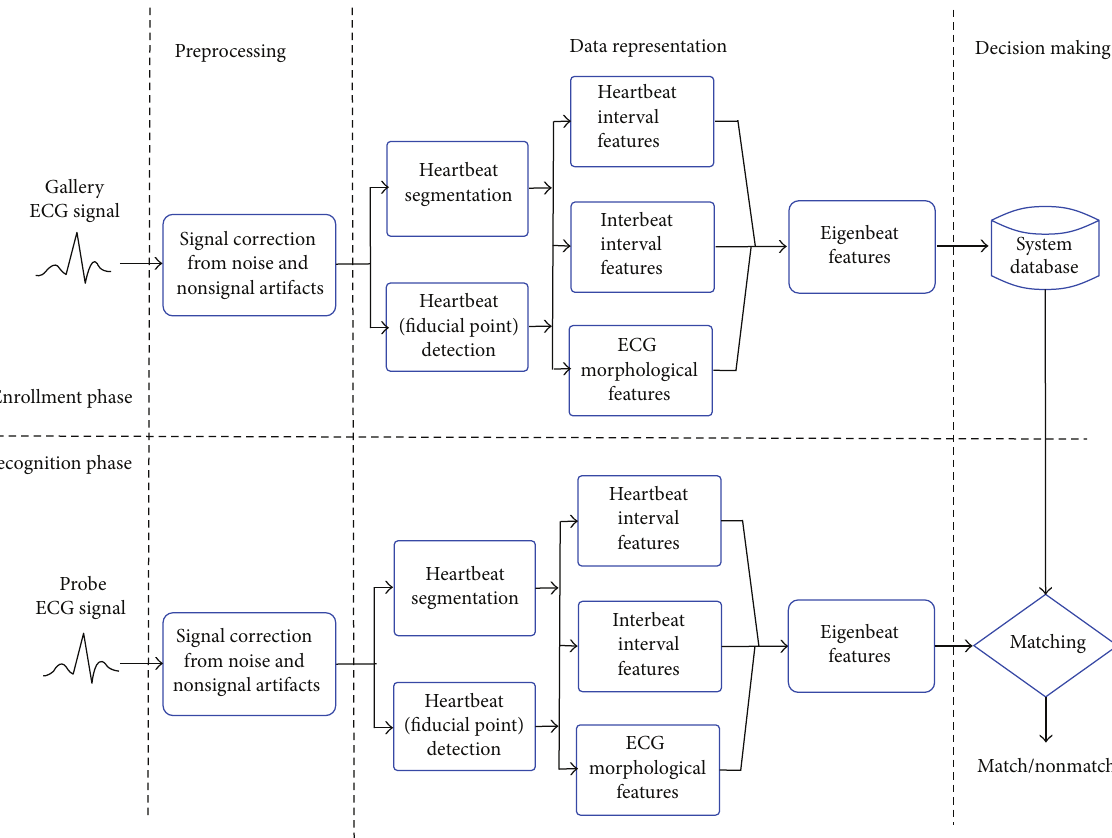
Figure 4: Schematic representation of ECG biometric system. The system performs automated characterization of the ECG signal and extraction of eigenbeat features for individual